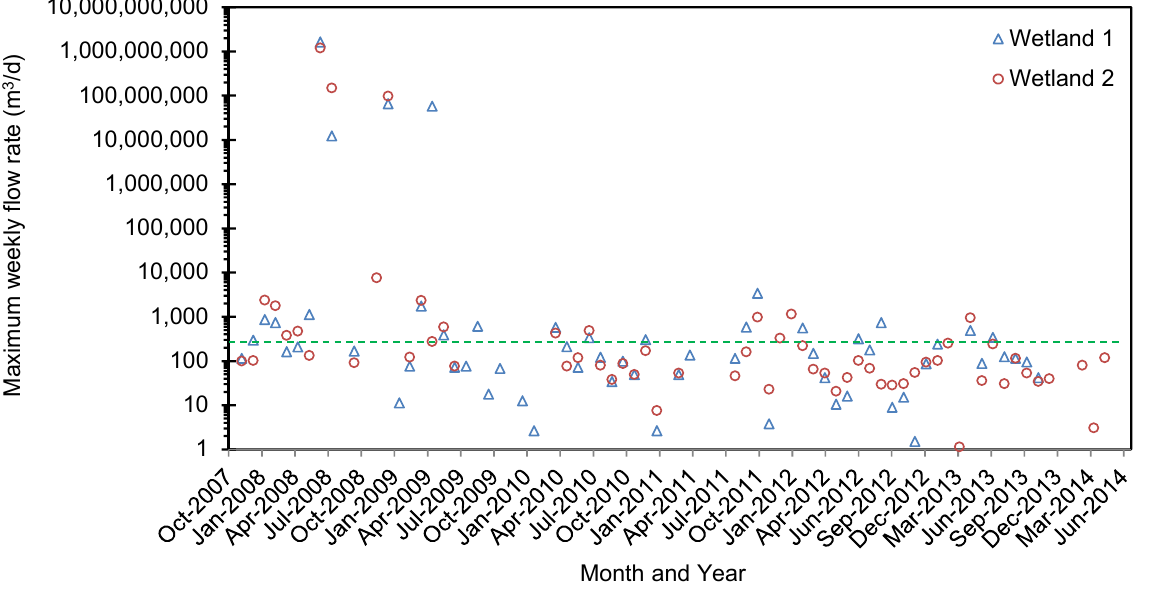
Figure 6. Maximum weekly CSO inflow to Akron constructed wetlands. Green dash line represents the weekly flow to meet the design CSO volume in a week. 24 values smaller than 1 are not shown in the log graph. Data source: USEPA [8].